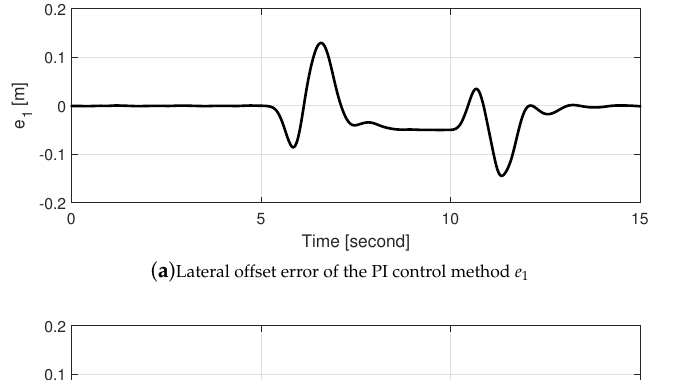
Figure 13. Steering angle.